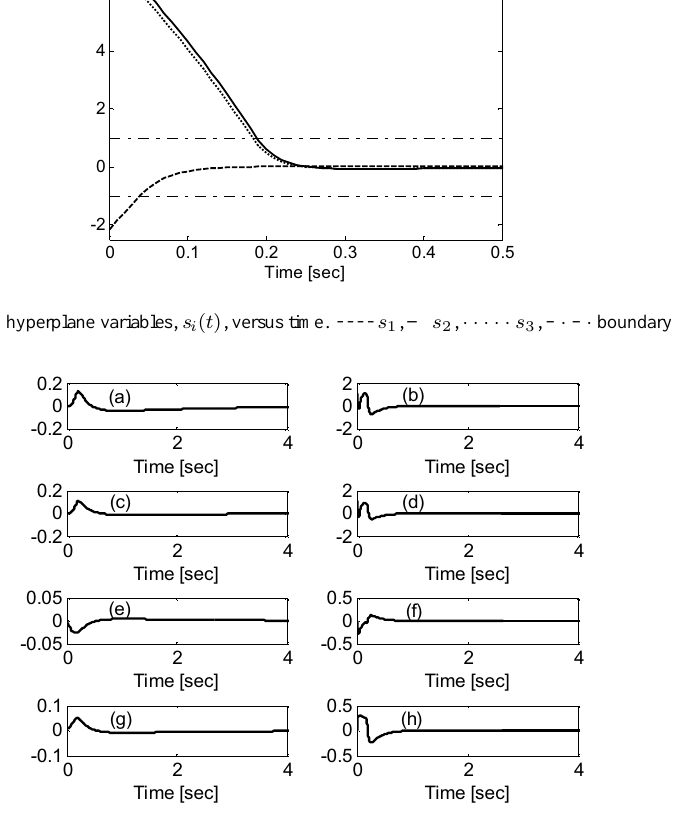
Fig. 4. Controlled states versus time ( δ j = 0 . 15 ( j = 1 , · · · , 8) or (cid:4) ∆ o (cid:4) ∞ = 0 . 15) (a) x 1 . (b) x 2 . (c) x 3 . (d) x 4 . (e) x 5 . (f) x 6 . (g) x 7 . (h) x 8